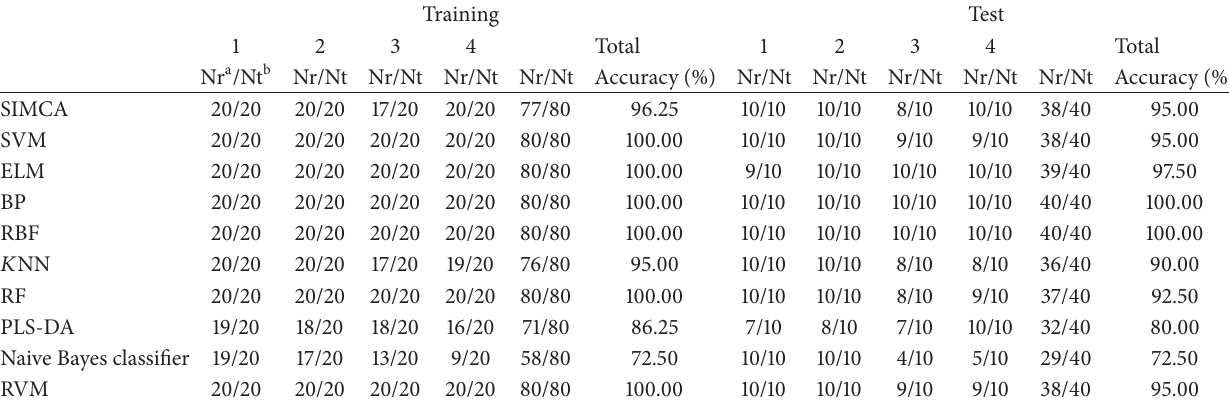
Table 2: Classification results of the models on optimal wavenumbers.